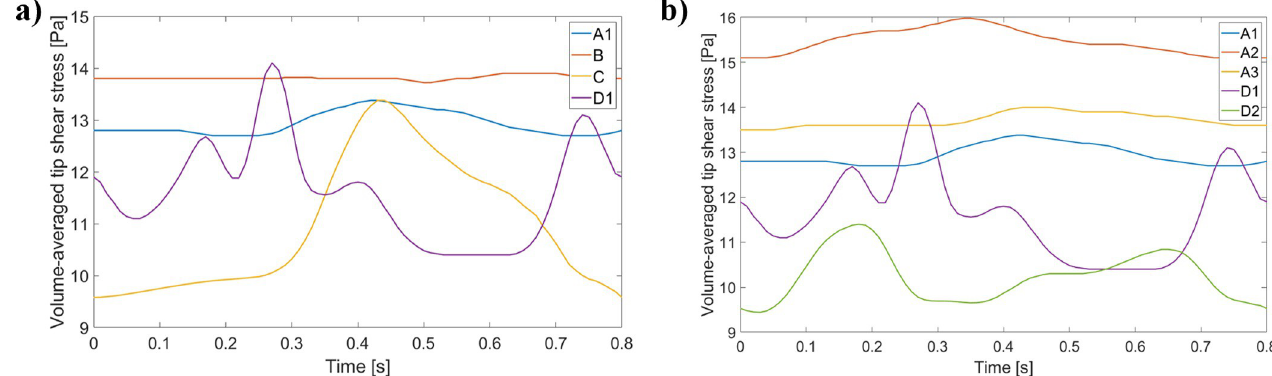
Fig 16. Volume-averaged shear stress profile through the cardiac cycle for all catheter venous lumen tips (generated with data from S13 File). (a) All designs are present; (b) A and D tip placement changes impact on tip shear stress.